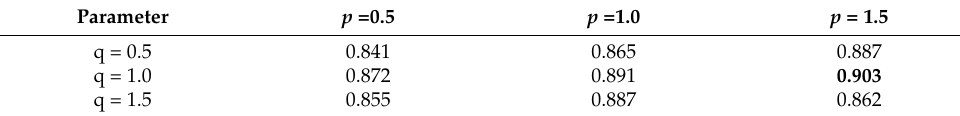
Table 4. Experimental results for different parameter settings on Wiki-Vote dataset. Parameter p =0.5